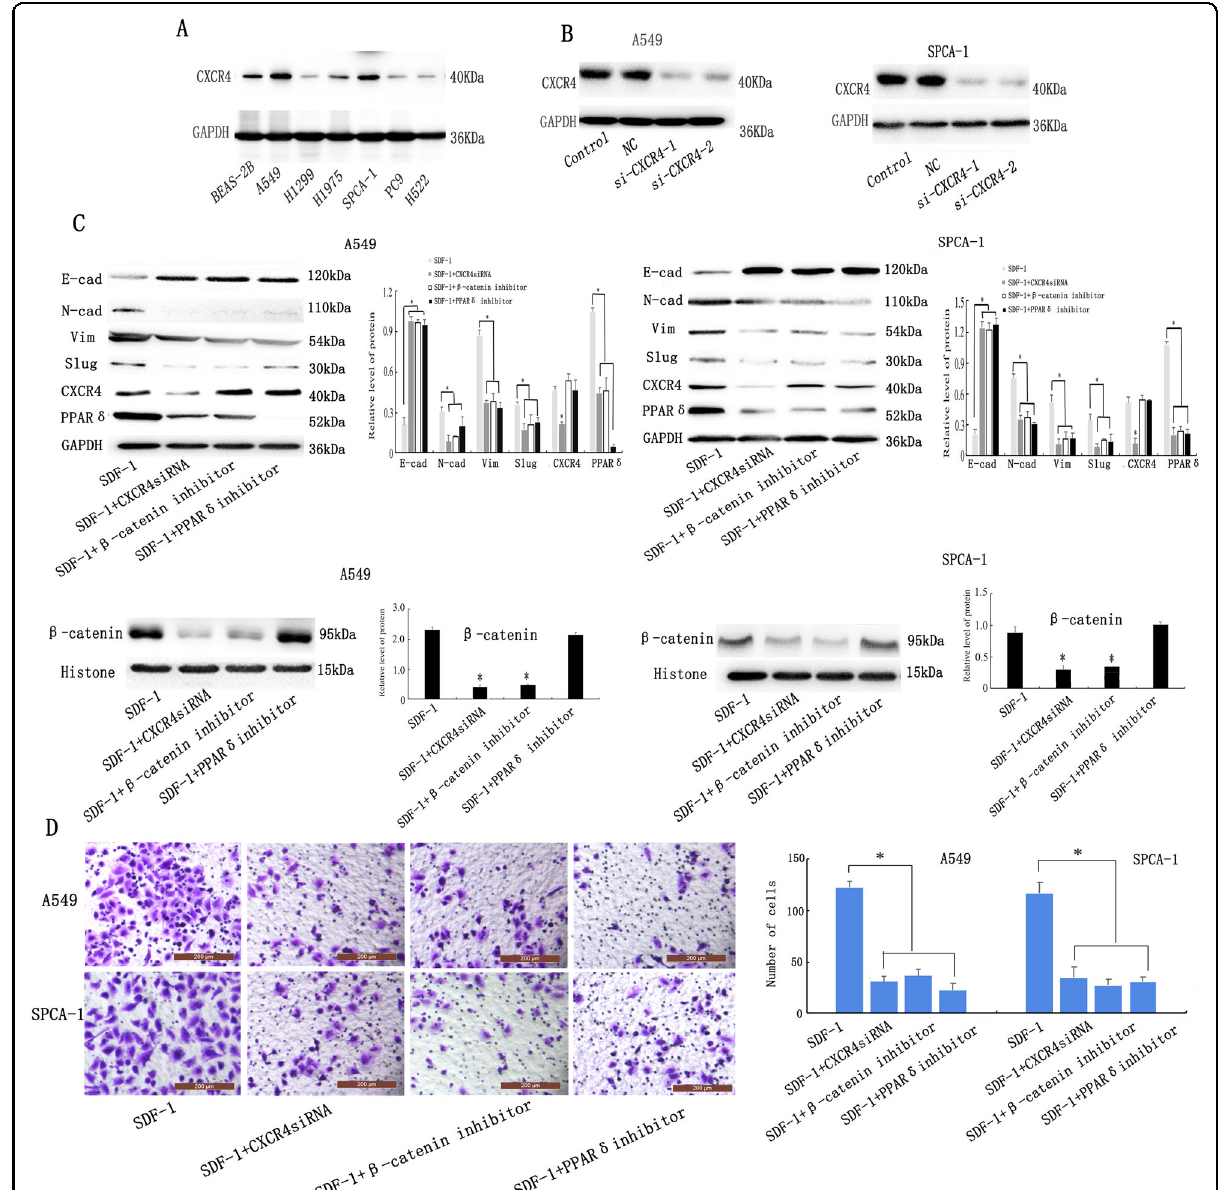
Fig. 6 SDF-1 induces EMT of lung ADC cells via CXCR4/ β -catenin/PPAR δ signalling. a , b The expression of CXCR4 expression was detected using western blotting in several lung ADC cell lines. Compared with control cells ( b ), higher CXCR4 expression was observed in A549 and SPCA-1 cells ( a ), and lower CXCR4 expression was observed in CXCR4 knockdown cells. c Western blotting was used to detect CXCR4, β -catenin, PPAR δ and EMT-related proteins (vimentin, N-cadherin, Slug, and E-cadherin) in A549 and SPCA-1 cells. d Transwell analysis showed that CXCR4 knockdown, or inhibition of β -catenin and PPAR δ eliminated the invasion induced by SDF-1; scale bar: 200 μ m. Data are representative images and numerical data are represented as the mean ± SD of each group of cells from three separate experiments. * p <